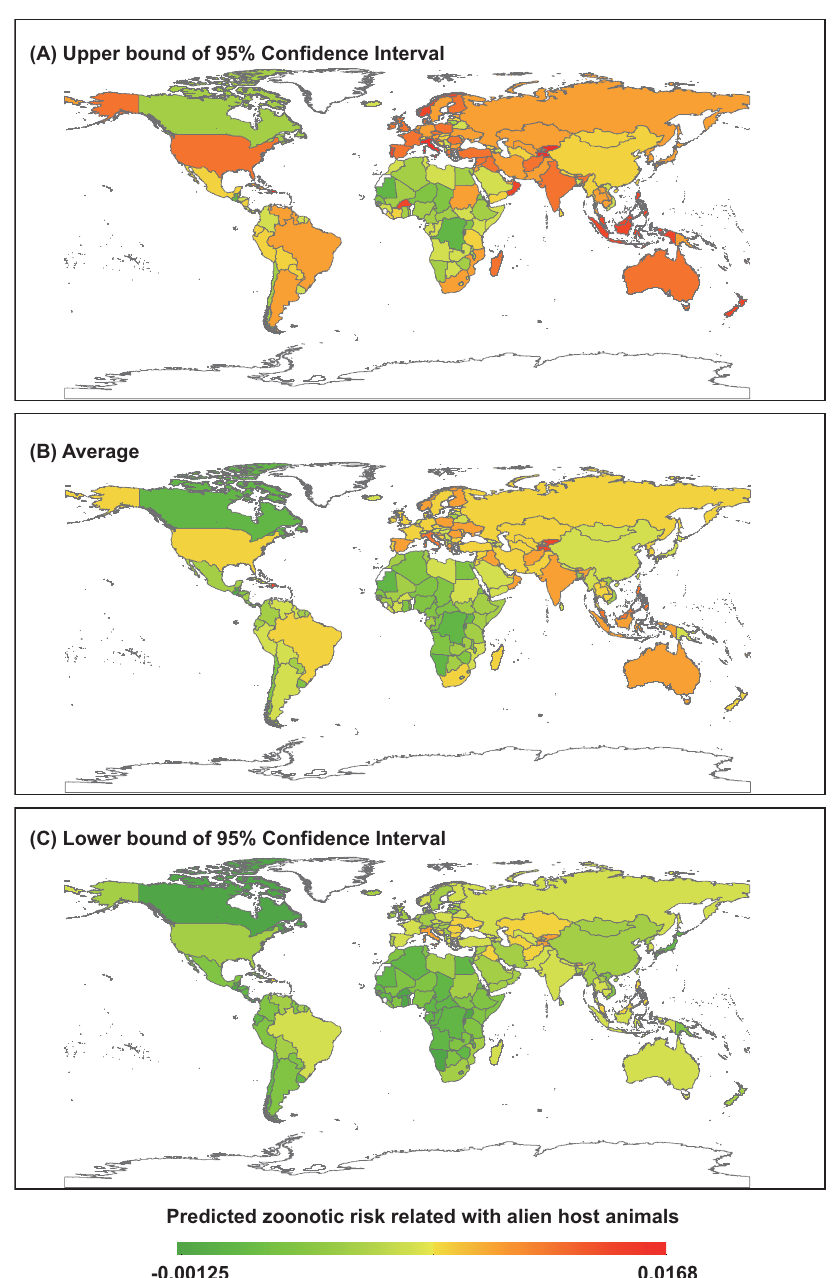
Fig. 6 Global map showing the potential contribution of alien zoonotic host introductions to zoonosis events of each administrative area at the global scale. Maps are derived for predicted zoonosis events caused by alien host species and the relative risk is calculated by subtracting the GAMM fi tted values excluding the zoonotic host introduction from those using all predictor variables in Supplementary Data